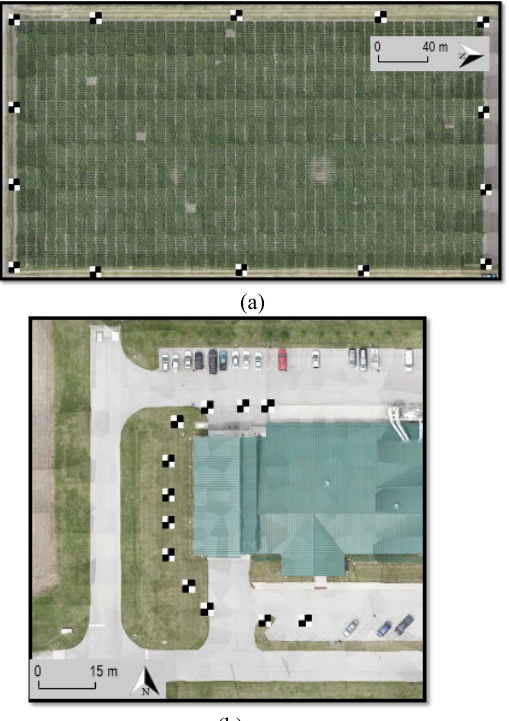
Figure 2. Sample orthophotos of the study sites along with an enhanced representation of the ground targets: (a) Agriculture filed, and (b) Building datasets.